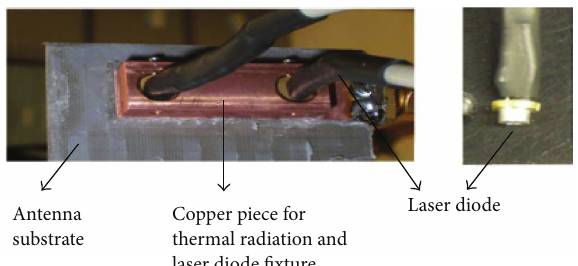
Figure 5: Integration of the laser diode into the antenna structure